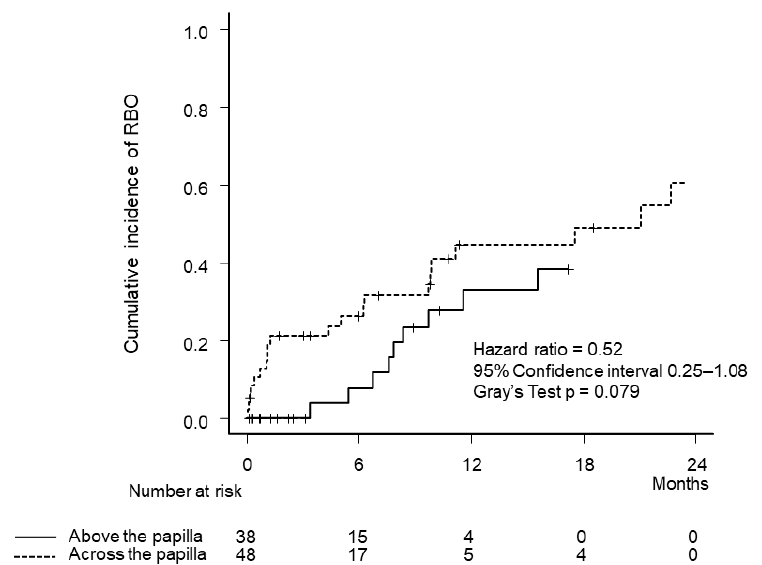
Figure 3. Cumulative incidence of recurrent biliary obstruction by stenting methods. RBO, recurrent biliary obstruction.